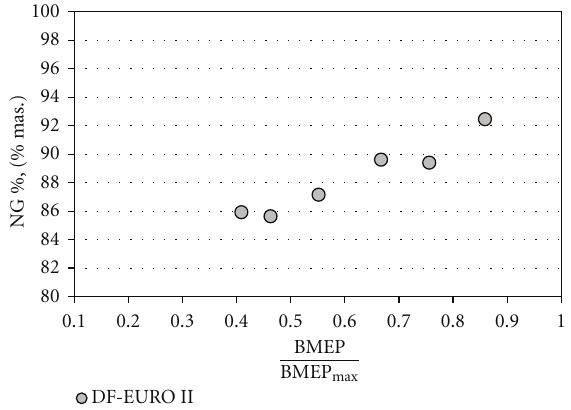
Figure 10: Natural gas fraction for DF engines measured in the condition of Figure 4.